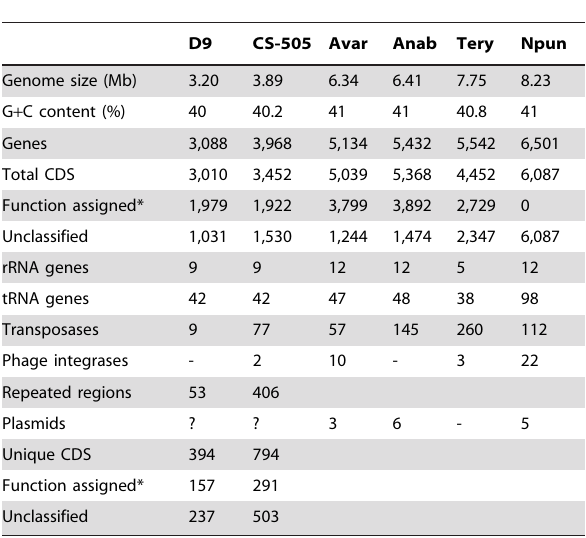
Table 2. General features of the genomes of strains CS-505 and D9 in comparison with four other fully sequenced genomes of filamentous cyanobacteria.